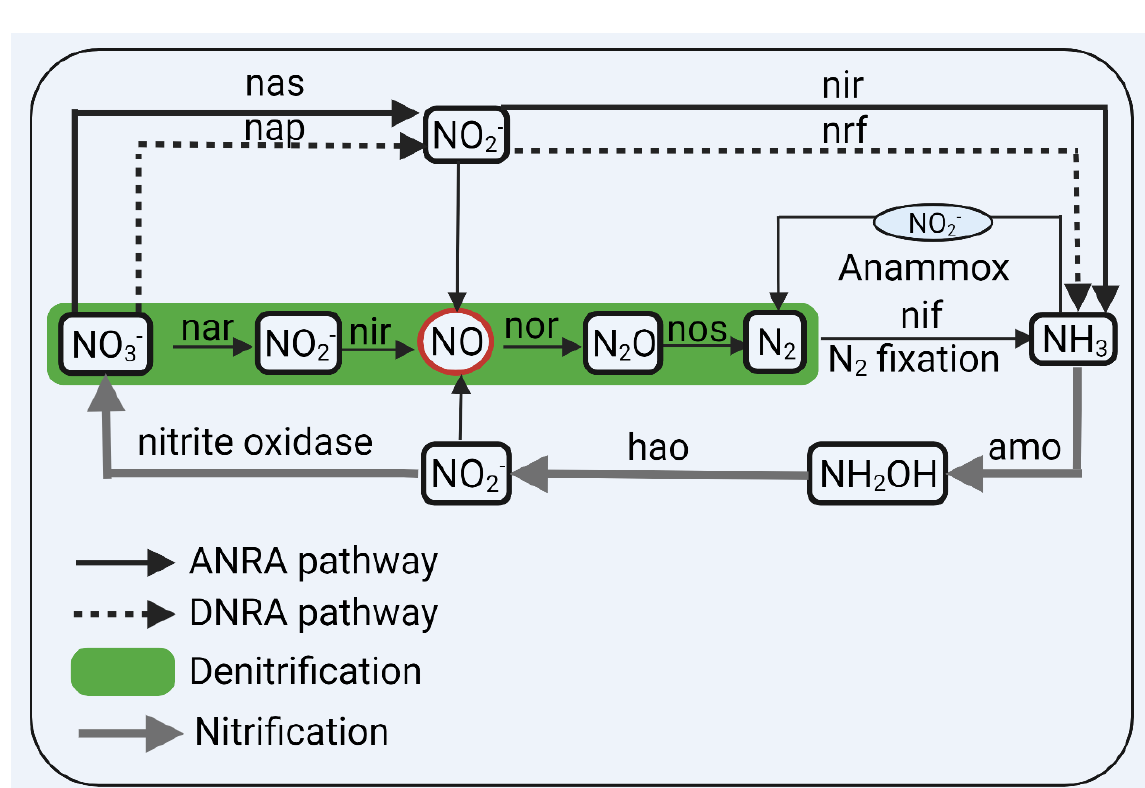
Figure 2: The nitrogen cycle in bacteria. Nitrate (NO 3- ) is converted to ammonia (NH 3 ) via ANRA (as- similatory nitrate reduction to ammonia), DNRA (dissimilatory nitrate reduction to ammonia), and deni- trification pathways. Dinitrogen (N 2 ) fixation converts N 2 to NH 3 . NH 3 is converted to NO 3- aerobically (nitrification) or anaerobically via the anammox (anaerobic ammonium oxidation) process. nas, nap, nar are nitrate reductases, and nir and nrf are nitrite (NO 2- ) reductases. amo, ammonia oxidase; hao, hy- droxylamine oxidoreductase; N 2 O, nitrous oxide. Created with